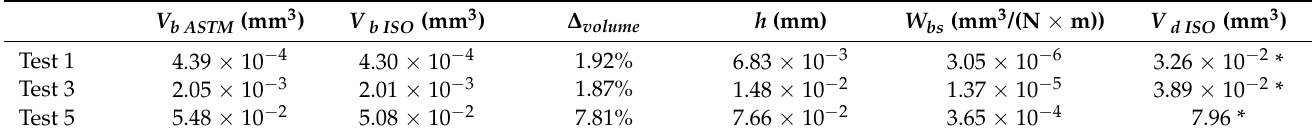
Table 8. Surface roughness values of disks before testing.